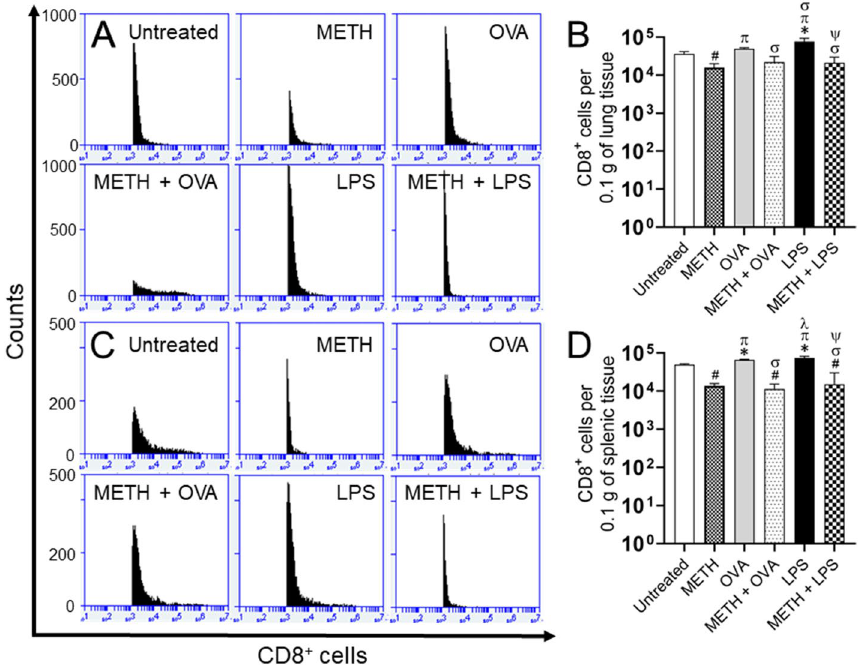
Figure 6. METH injection reduces the infiltration of CD8 + T cells to the lungs and spleen of mice sensitized with OVA or LPS. (A,B) Pulmonary and (C,D) splenic tissue was excised ( n = 5 animals per group), 0.1 g weighed, and homogenized at 7 post-antigenic challenge. Samples were stained with fluorescence-labeled mAb for CD8 + T cells and analyzed using flow cytometry. Representative plots are shown. Each plot was generated after 10,000 events were analyzed. For each graph, bars represent the mean values; error bars indicate standard deviations. Symbols (*, π, , λ, #, σ, and ψ) indicate P value significance ( P < 0.05) calculated using ANOVA and adjusted by use of the Tukey’s post-hoc analysis. *, π, and λ indicate significantly higher CD8 + cell infiltration ϕ than in the untreated, METH, and METH + OVA-treated groups, respectively. #, σ, and ψ indicate significantly lower CD8 + cell infiltration than in the untreated, OVA, and LPS-treated groups, respectively. The experiments were performed twice and similar results were